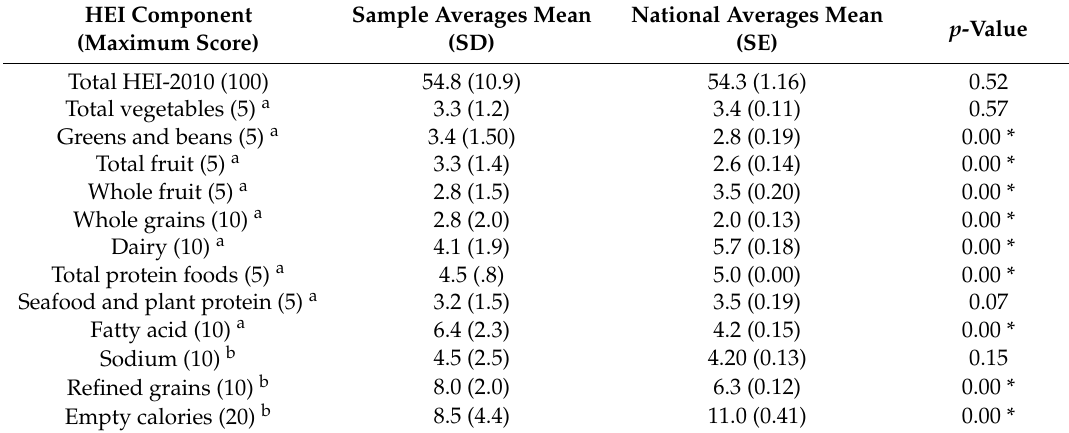
Table 2. Comparison of total HEI and subcomponents among study participants and national